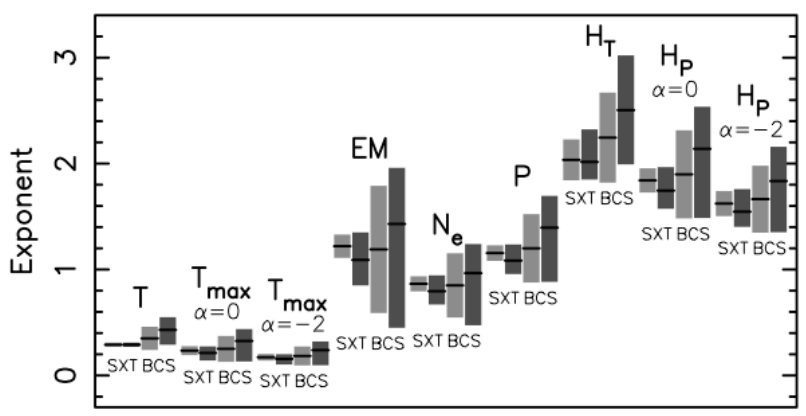
Figure 29: Ranges for the exponents found for the mean physical parameters in the scaling law equations: parameter ∝ ¯ 𝐵 exponent ( ¯ 𝐵 : magnetic flux density). The temperature, 𝑇 , and the emission measure, EM, are derived directly from the observations, then the plasma density, 𝑁 𝑒 , and pressure, 𝑃 , are deduced. 𝑇 max is the maximum temperature derived from the quasi-static thermal model of coronal loops. 𝐻 𝑇 and 𝐻 𝑃 are the heating rate derived from the observations and the thermal model. For 𝑇 max and 𝐻 𝑃 two values of 𝛼 are shown (coronal radiative losses ∝ 𝑇 𝛼 ). The ± 3 𝜎 error range of a normally distributed statistics is light shaded. The 90% confidence interval of the non-parametric statistics is dark shaded. Image reproduced with permission from D´emoulin et al. (2003), copyright by